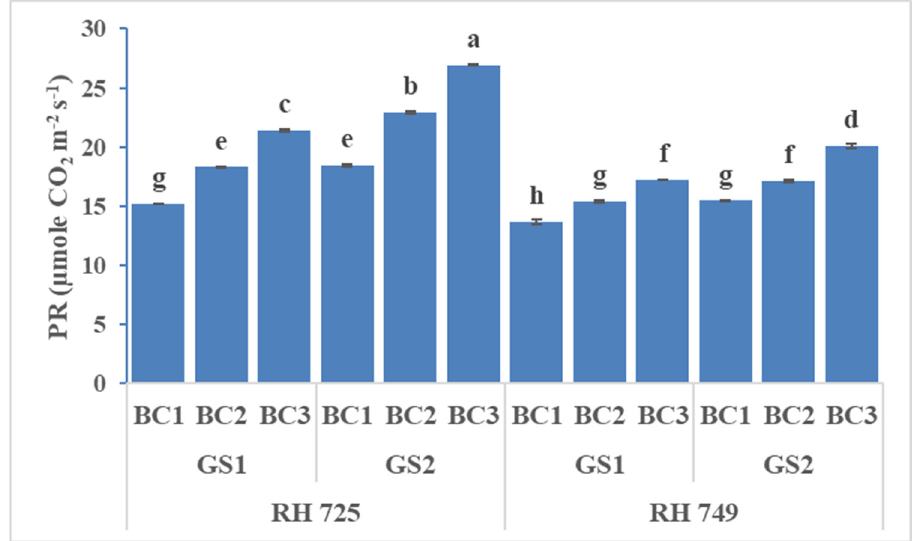
Figure 2. Comparisons of the effects of different concentrations of brassinolide sprays (BC1: control (water spray); BC2: 10 mg BRs/L water; BC3: 20 mg BRs/L water) on the photosynthetic rate (PR) of drought-tolerant (RH 725) and drought-sensitive (RH 749) Indian mustard cultivars at the flower initiation (GS1) and 50% flowering (GS2) stages. Columns marked by different letters indicate significant differences ( p < 0.05) between treatments based on Duncan’s multiple range test. Error bars denote the standard errors of the mean.